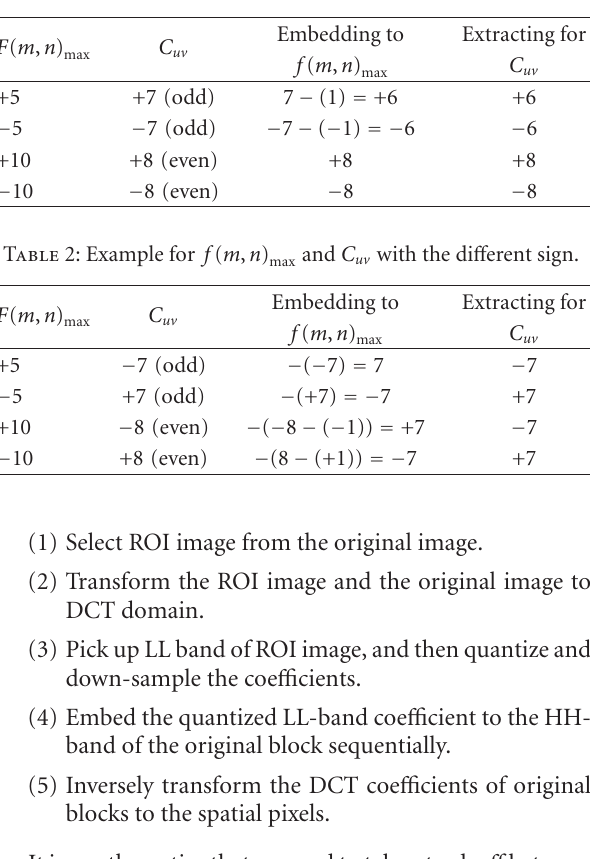
Table 1: Example for f ( m , n )